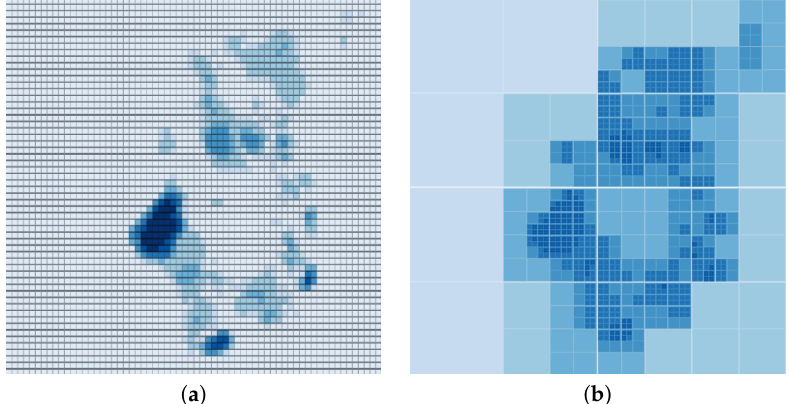
Figure 8. Visualization of the mountain flooding using ( a ) regular grids, ( b ) adaptive grids.